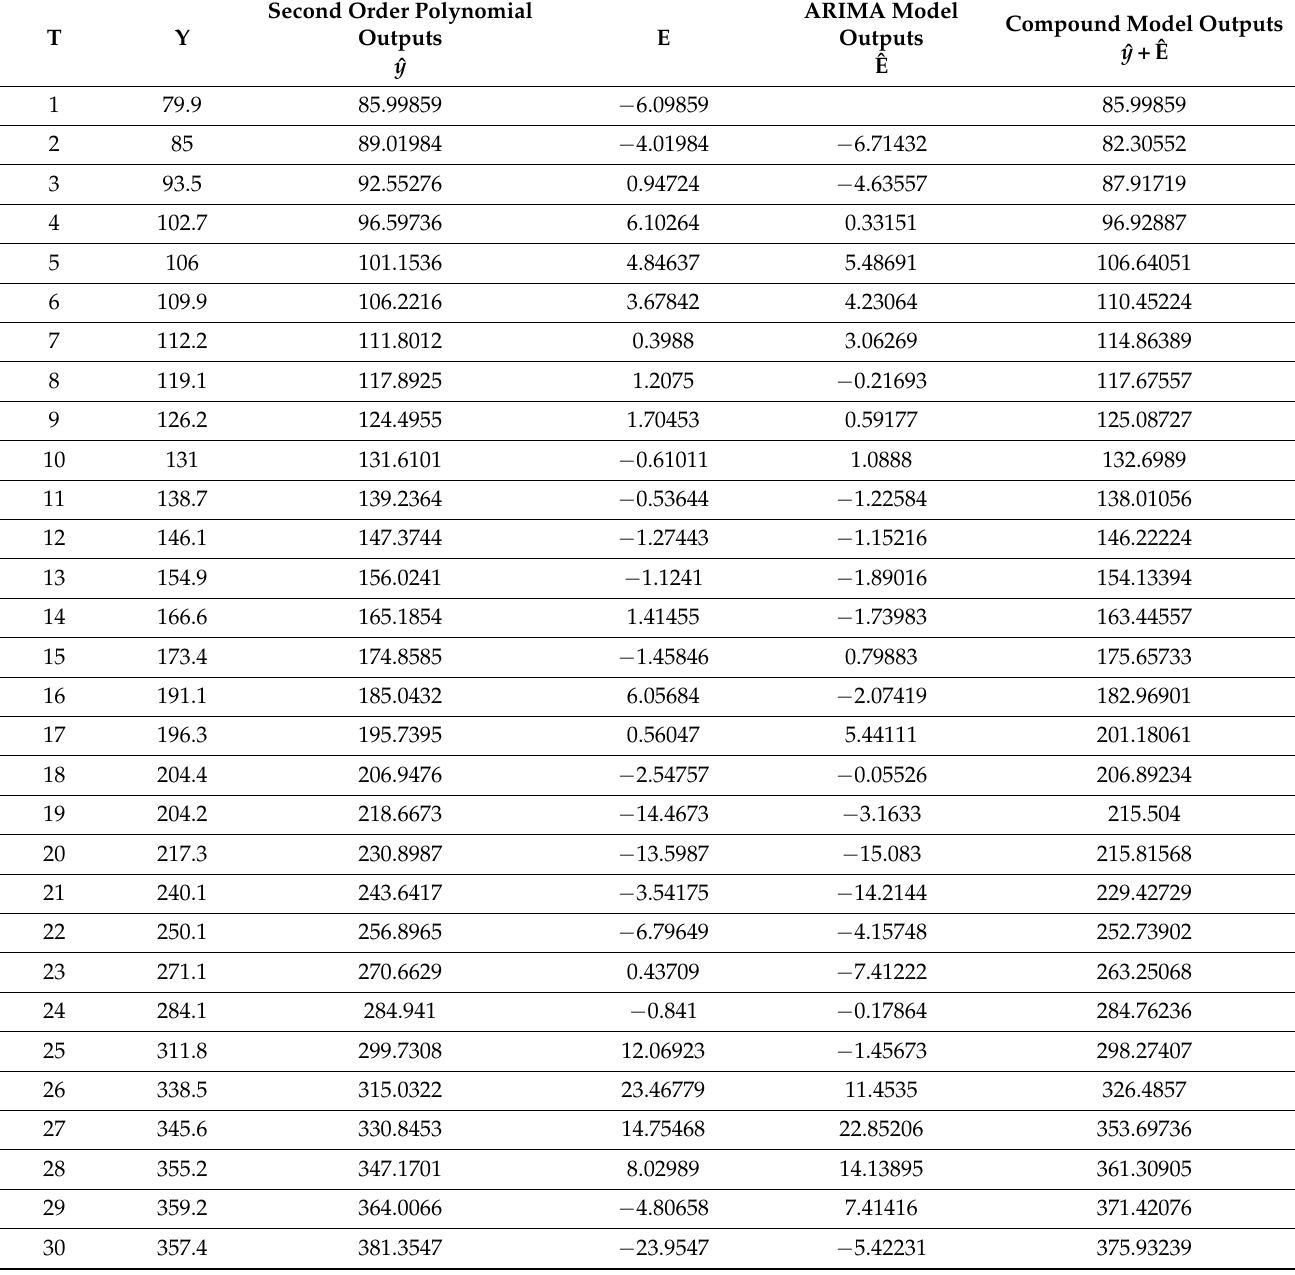
Table A9. Synthesis of the second order polynomial outputs with the ARIMA model outputs.